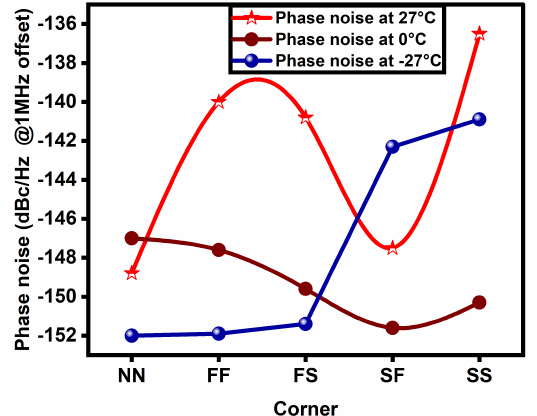
Figure 7. Phase noise comparison plot of proposed PLL among various corners at different